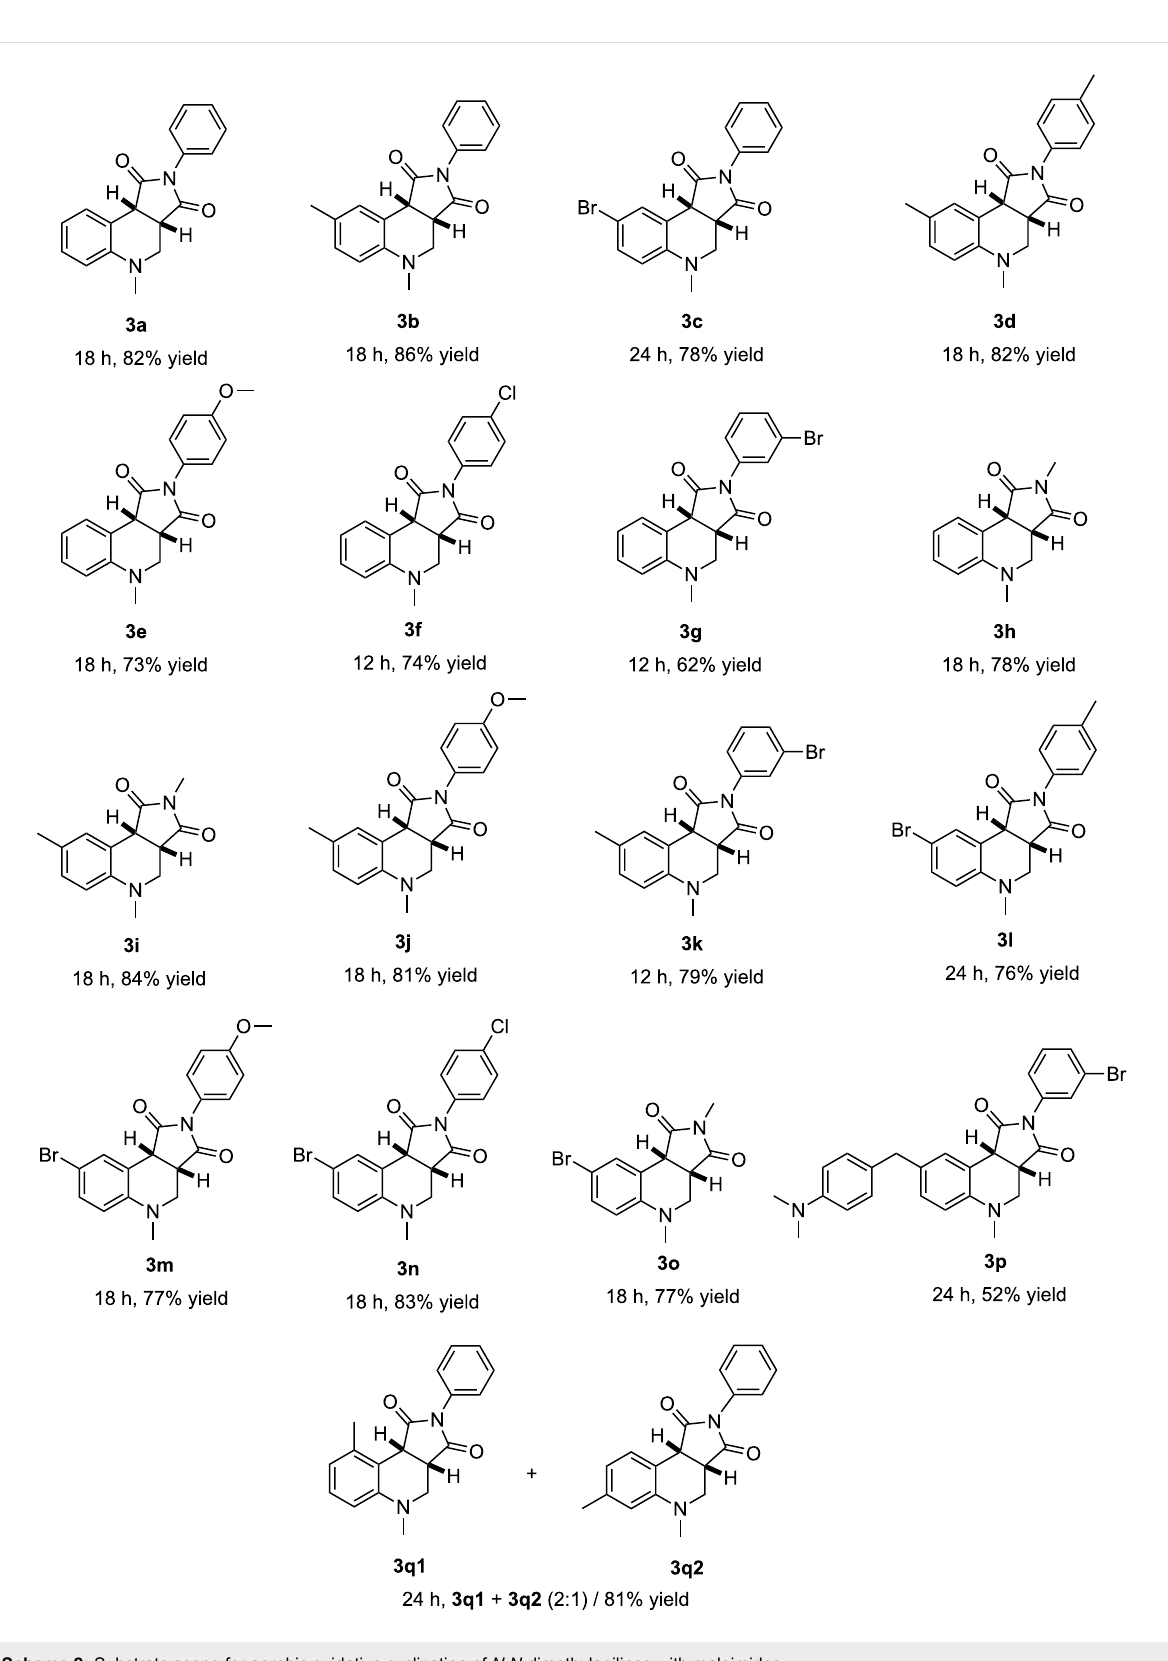
Scheme 2: Substrate scope for aerobic oxidative cyclization of N , N -dimethylanilines with